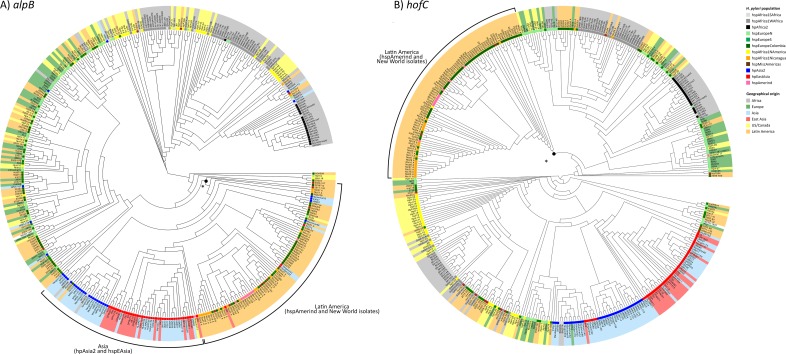
Maximum likelihood phylogenetic trees of alpB and hofC genes.Leaves are shaded according to geographical origin and the H. pylori population assignment according to the FineSTRUCTURE analysis is marked at the base of each leaf. A) AlpB. A black dot with an asterisk marks the branch for which the joint Latin American and Asian clade segregate from the others. B) HofC. The black dot with an asterisk marks the branch at which the South American clade segregates from the others.